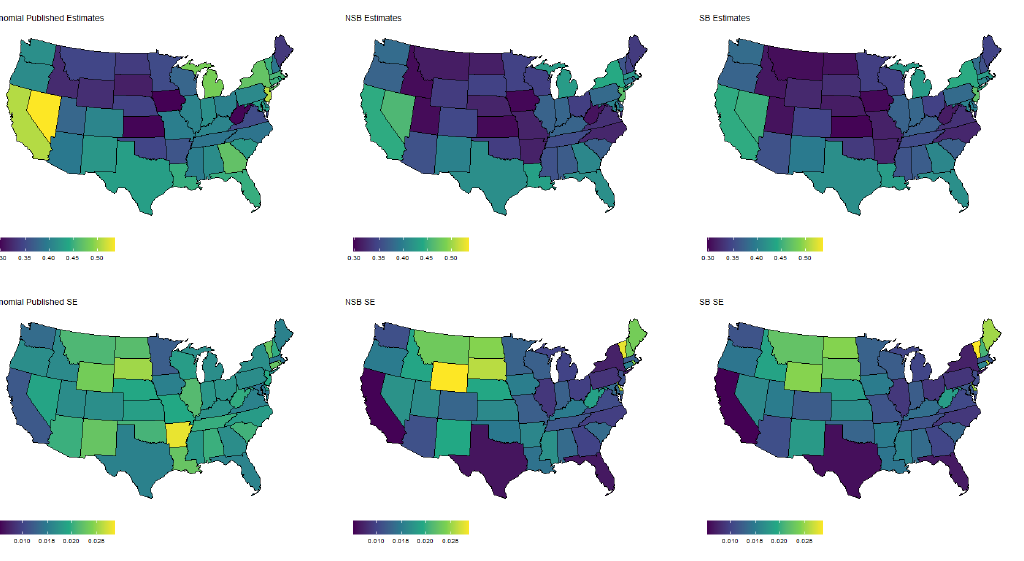
Figure 3. Estimated population proportion of people who expect to lose their job by state and estimator along with corresponding standard error for Week 1 of the Household Pulse Survey. Estimates are plotted on the same color scale, and standard errors (SEs) are plotted on another color scale.